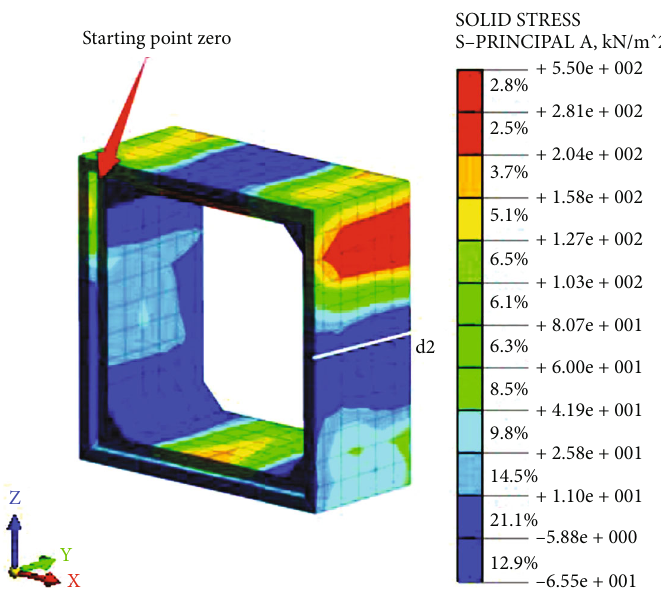
Figure 9: Contour map of the maximum principal stress on the N